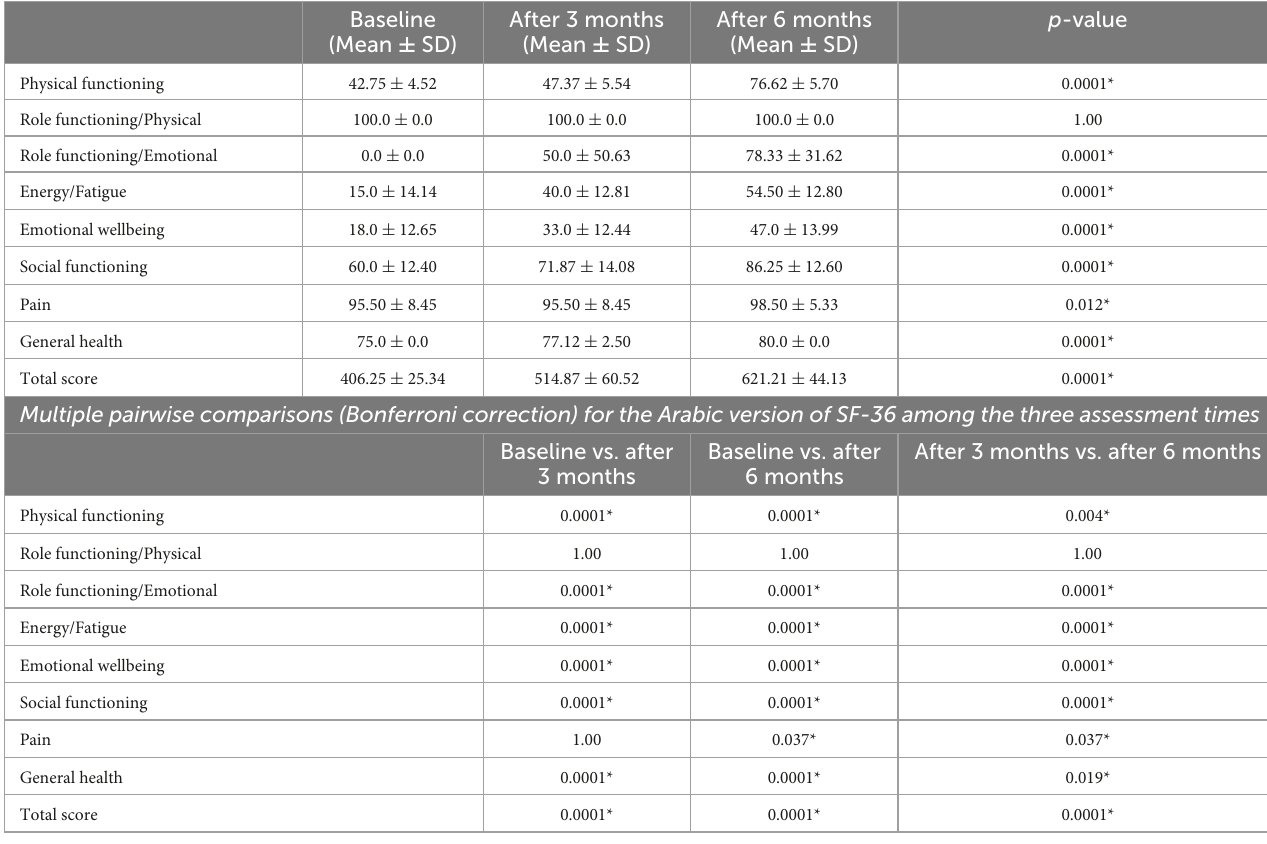
TABLE 5 Quality of life assessed by the Arabic version of SF-36 among the three assessment